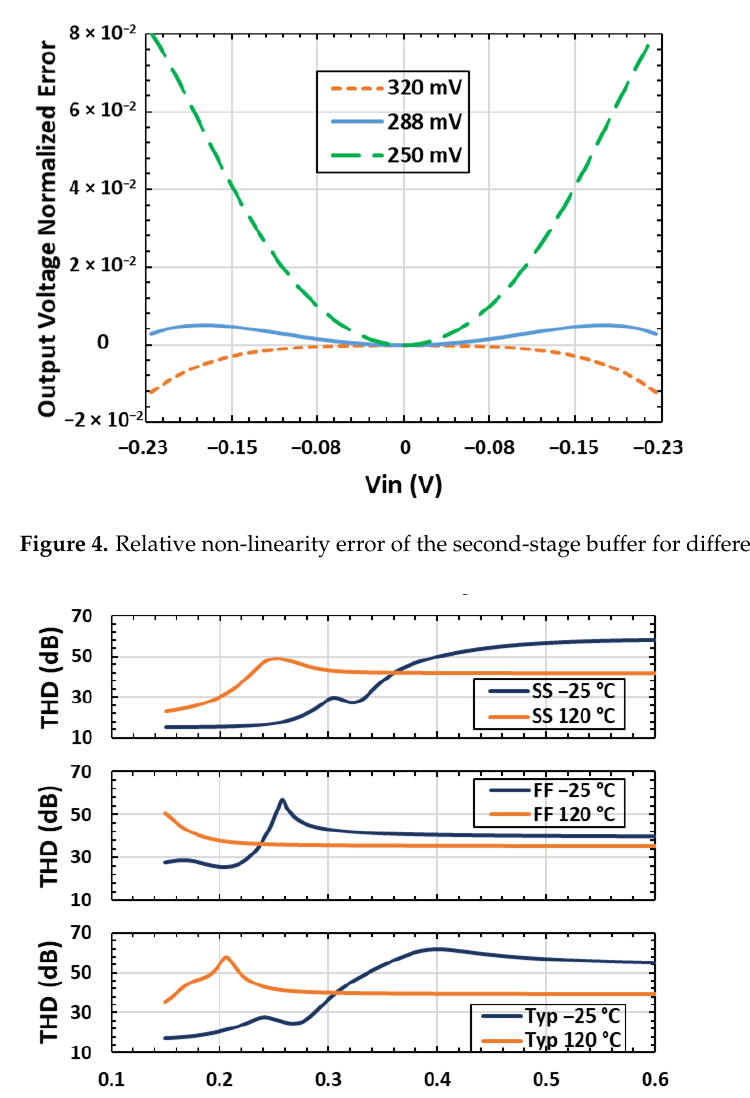
Figure 5. Second-stage buffer linearity characterization for different PVT conditions.